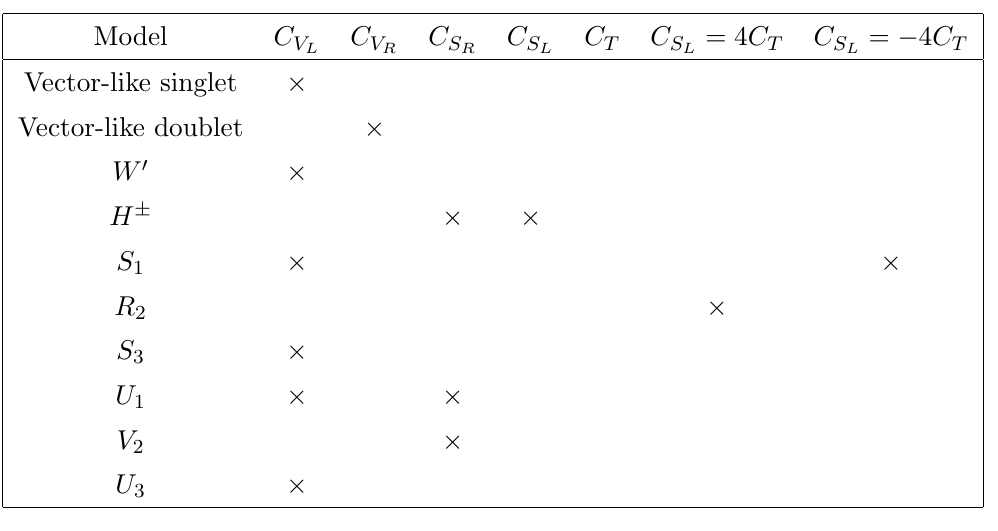
Table 2 . Pattern of Wilson coe(cid:14)cients generated by tree-level models. Crosses correspond to a possible e(cid:11)ect at the matching scale. If two crosses appear in a line, the contributions are governed by independent parameters in the